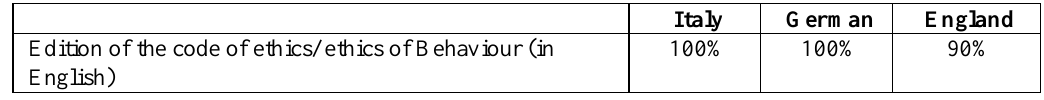
Table 2: Level of Transparency on the Code of Ethics